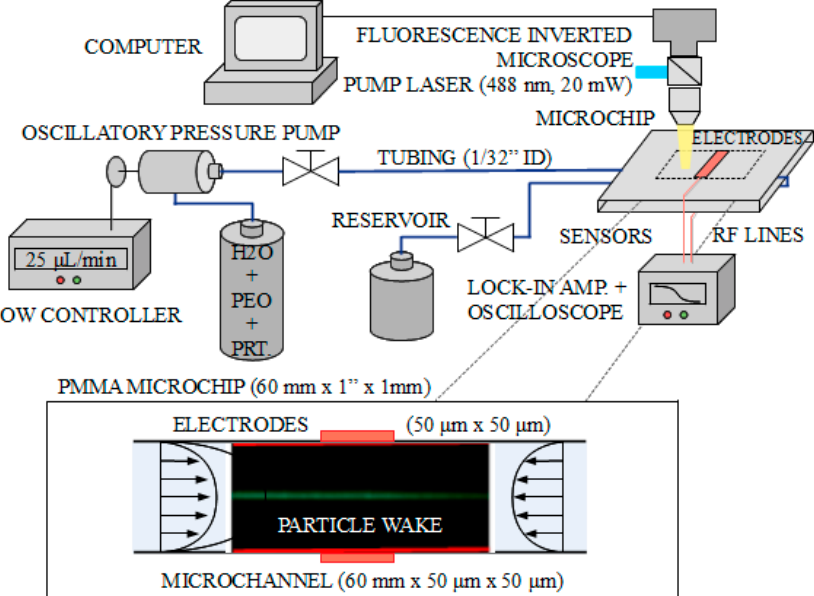
Figure 7. Schematics of the experimental setup. The system is computer controlled and consists of an inverted fluorescence microscope with image sensor, a pressure-driven flow-controlled microfluidic pump, and an electromagnetic measurement station composed of a lock-in amplifier and a visualization oscilloscope. The microfluidic chips used have connectorized square cross-section channels with cross-sections of 50 μm and 100 μm , and with a length of 60 mm . The electrodes are integrated within the microchips and connected through RF lines to the lock-in amplifier.